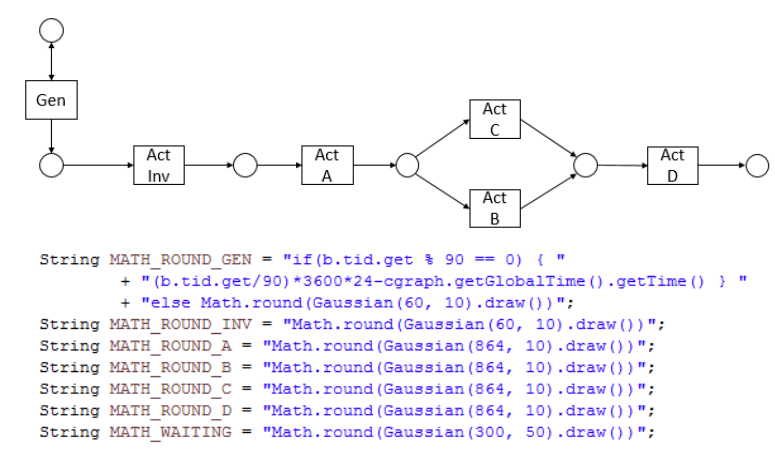
Figure 6. Based model to generate an artificial event